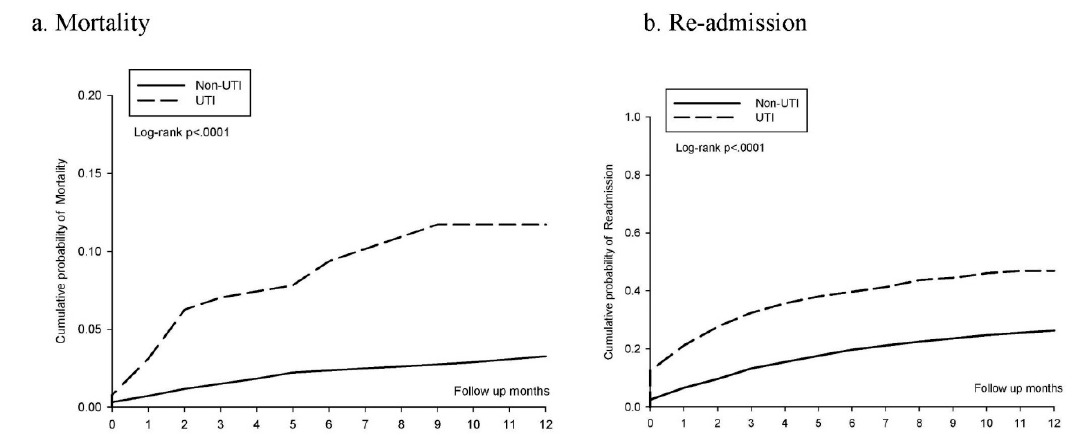
Figure 2. Kaplan–Meier curves of the cumulative proportions of mortality ( a ) and re-admission ( b ) in UTI and non-UTI. Table 3. Multiple Cox regression to estimate the hazard ratio for the mortality risk and re-admission.